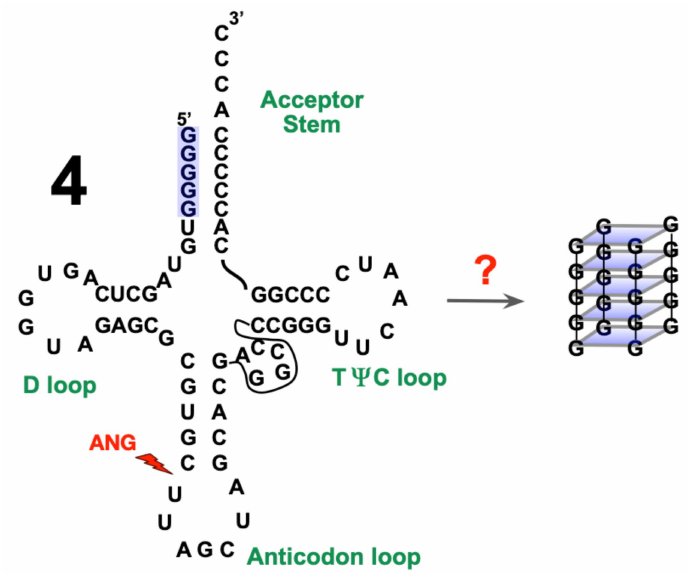
Figure 1. In cells, h-ANG is normally inhibited by the Ribonuclease Inhibitor (RI), which is highly sensitive to denaturation under mild oxidizing conditions [26]. Under cell stress conditions, RI could unfold, freeing h-ANG, which then cleaves tRNA in the anticodon loop (red lightning bolt) [27]. In this scenario, the 5 (cid:48) tRNA fragment, called tiRNA, has been shown to induce the formation of stress granules. The absence of this h-ANG activity is linked genetically to Amyotrophic Lateral Sclerosis (ALS). Four tiRNA have been proposed to tetramerize to form a G-quadruplex structure, although high resolution corroboration of this point is still